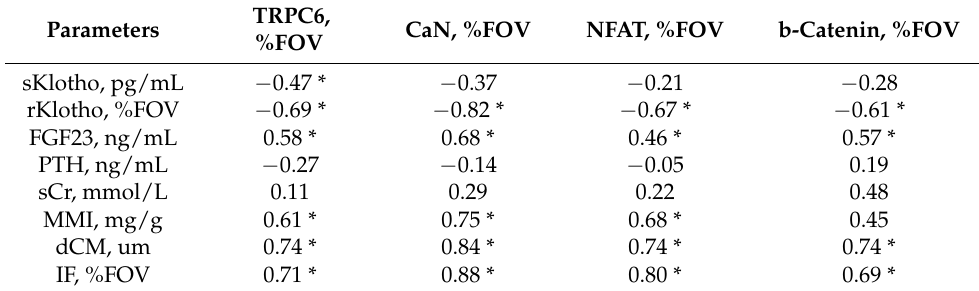
Table 2. Pooled correlation